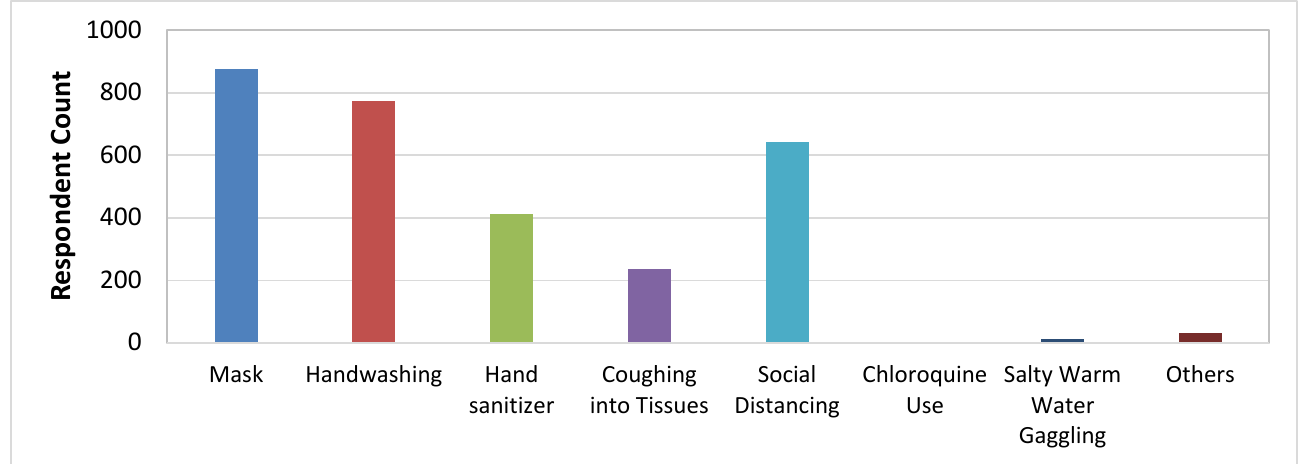
Figure 8. Palliatives distribution of the respondents.